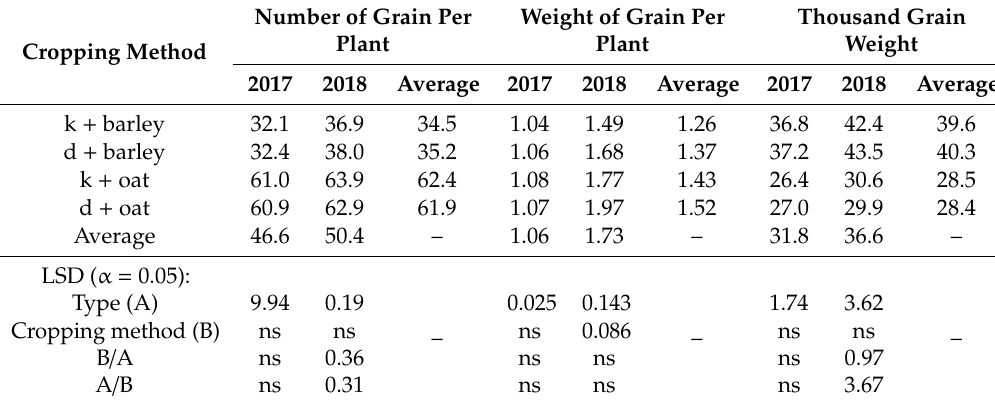
Table 9. Number, weight of cereal grains per plant (g) and thousand grain weight (g) of cereals depending on method sowing depending on type (k—kabuli; d—desi; ns—not significant at Tukey’s test P ≤ 0.05).